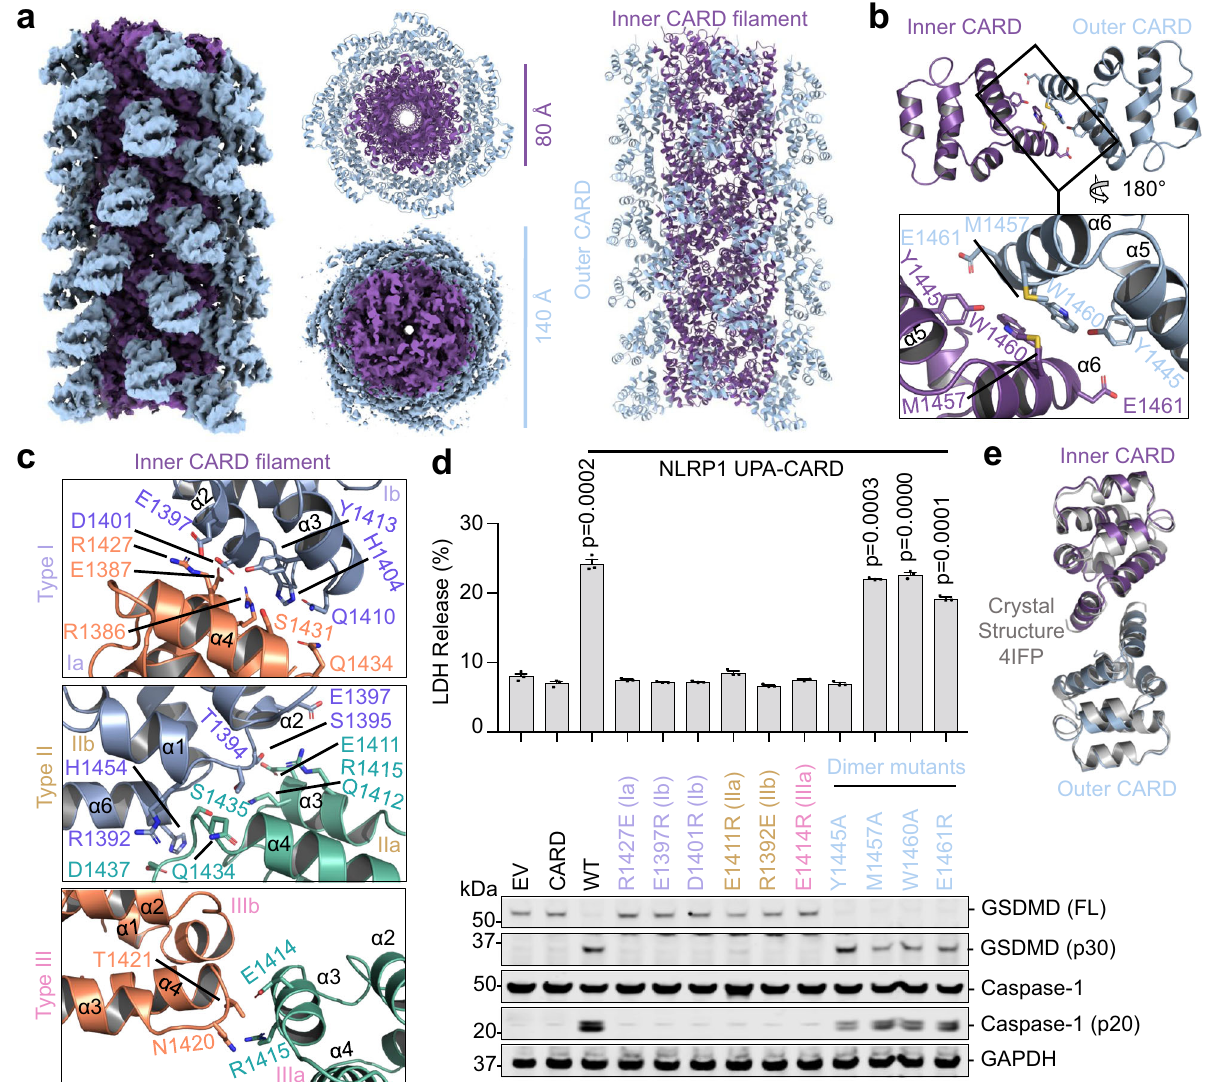
Fig. 4 Cryo-EM structure of the dimeric NLRP1 CARD fi lament. a Overall structure of the NLRP1-CT in fl ammasome. Each subunit of the inner helical CARD fi lament (purple) dimerizes with an outer CARD (blue). b Dimeric interface between an inner (purple) and outer (blue) CARD pair. c Zoom-ins of type I, II, and III helical interfaces between inner CARD molecules. d Structure-guided mutations of helical interfaces and the CARD – CARD dimer interface on UPA-CARD in fl ammasome signaling. LDH release (top) and western blot (bottom) are shown. P -values are compared to empty vector (EV) by two- sided Student ’ s t -test. Exact P -values are provided in the Source Data File. Data are means ± SEM of n = 3 biological replicates. In c , d residues and mutations are labeled in the colors of the interface types as de fi ned in Fig. 2c. e Alignment between Inner-outer CARD (purple and blue) and a dimer within the crystallographic symmetry unit of the NLRP1 CARD crystal structure